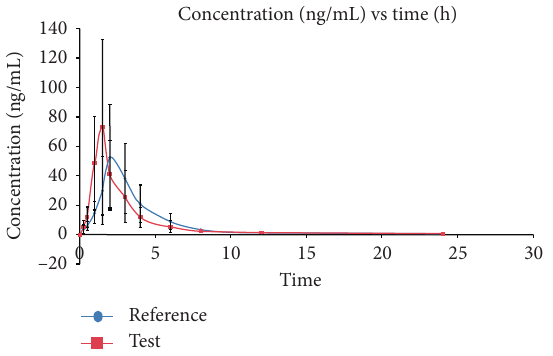
Figure 5: Mean plasma concentrations (ng/mL) versus time (h) of optimized formulation of vardenafil orodispersible tablet (test) and marketed orodispersible tablet formulation in New Zealand white rabbit (value expressed as mean ± SD with n �